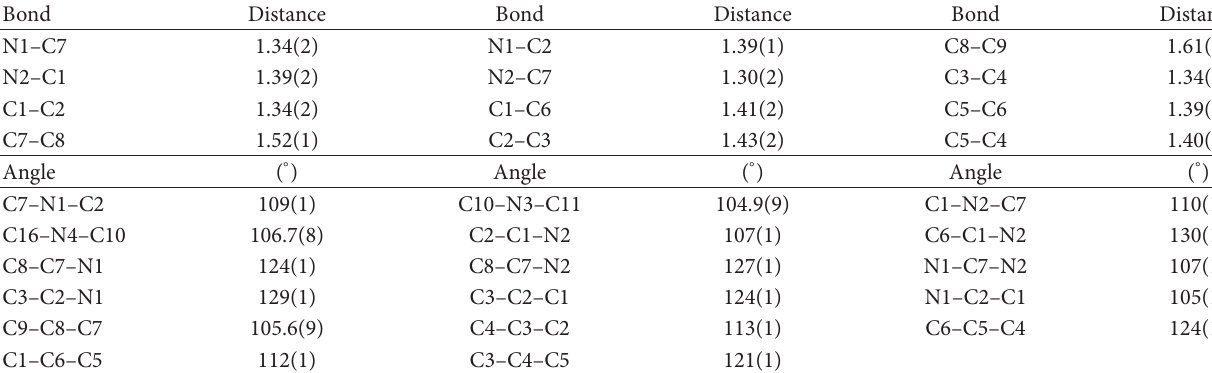
T 2: Selected bond lengths (Å) and bond angles (